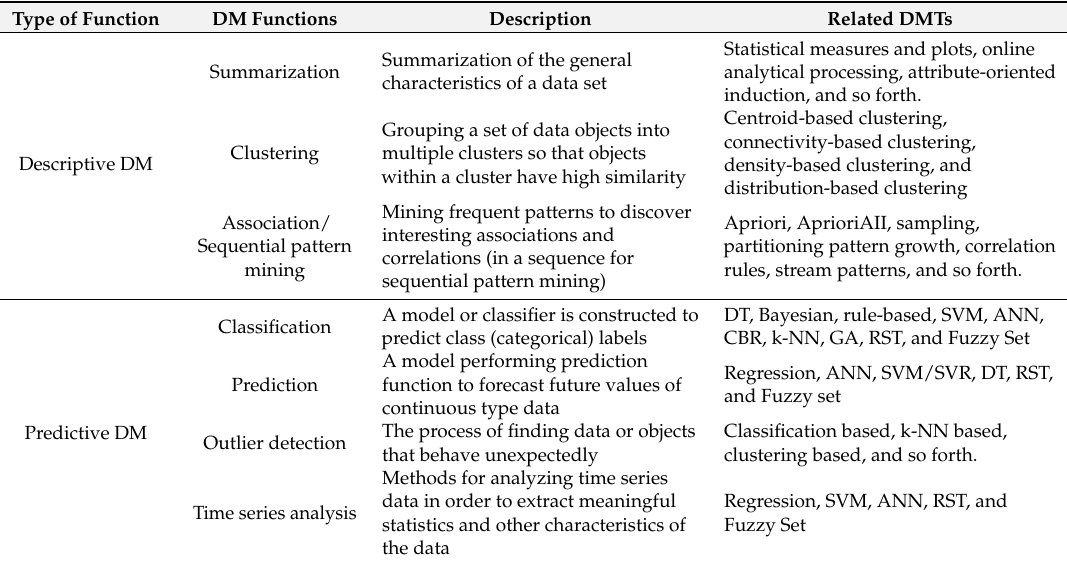
Table 2. The data mining functions and related techniques.